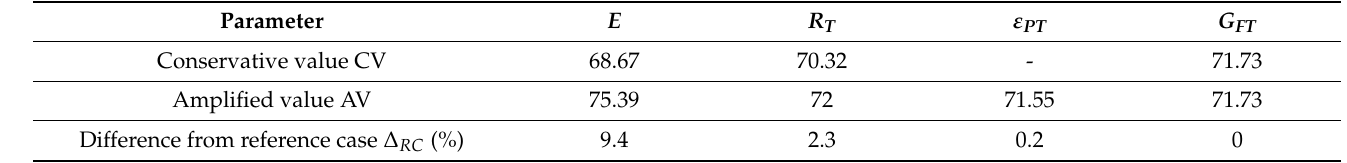
Table 5. Results of the sensitivity